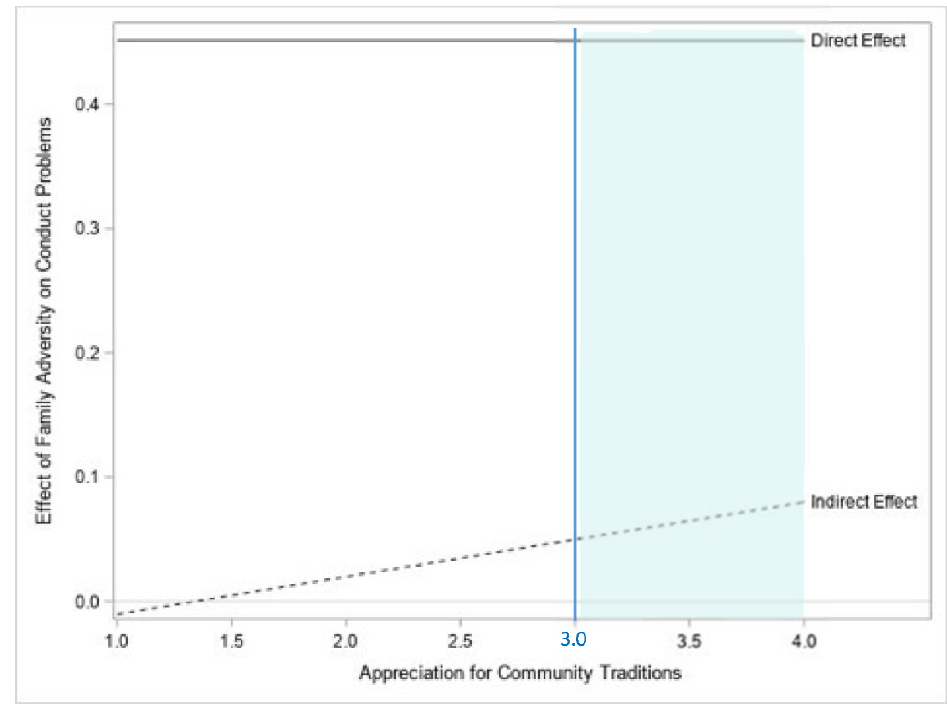
Figure 3. Visual representation of the conditional indirect and the direct effect of family adversity on the conduct problems of SA adolescents, with the indirect effect operating through family caregiving. The blue region to the right of the blue line represents the levels of appreciation for community traditions at which the indirect effect is statistically significant as indicated by bCIs.